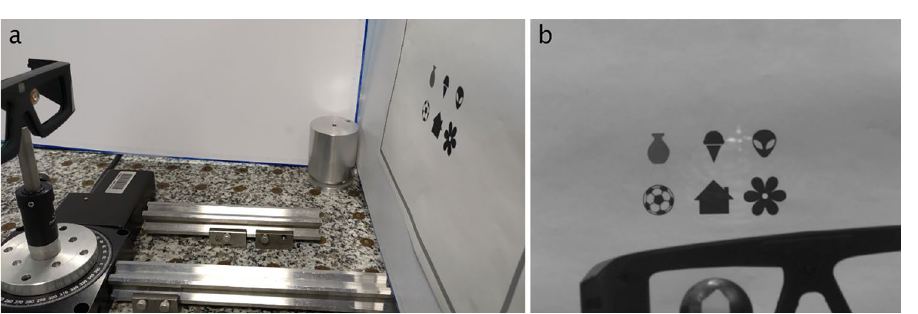
Figure 3. PSD response (in blue for the collimated VCSEL in red for the non-collimated one) as a function of spot position for different distances from the PSD: ( a ) 8.5 cm, ( b ) 20 cm, ( c ) 40 cm. If the VCSEL post size on the PSD is too large ( b , c ) then the PSD cannot accurately measure the spot position.